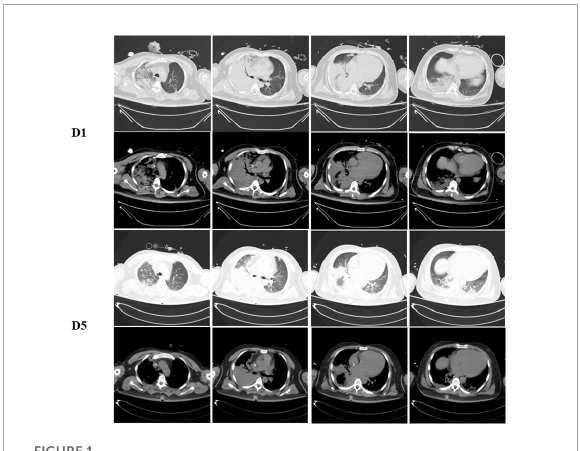
FIGURE1 Dynamic change on computed tomography chest of the patient. Chest CT scans show with large area consolidation of the right lung on day 1 and improved after 5 days